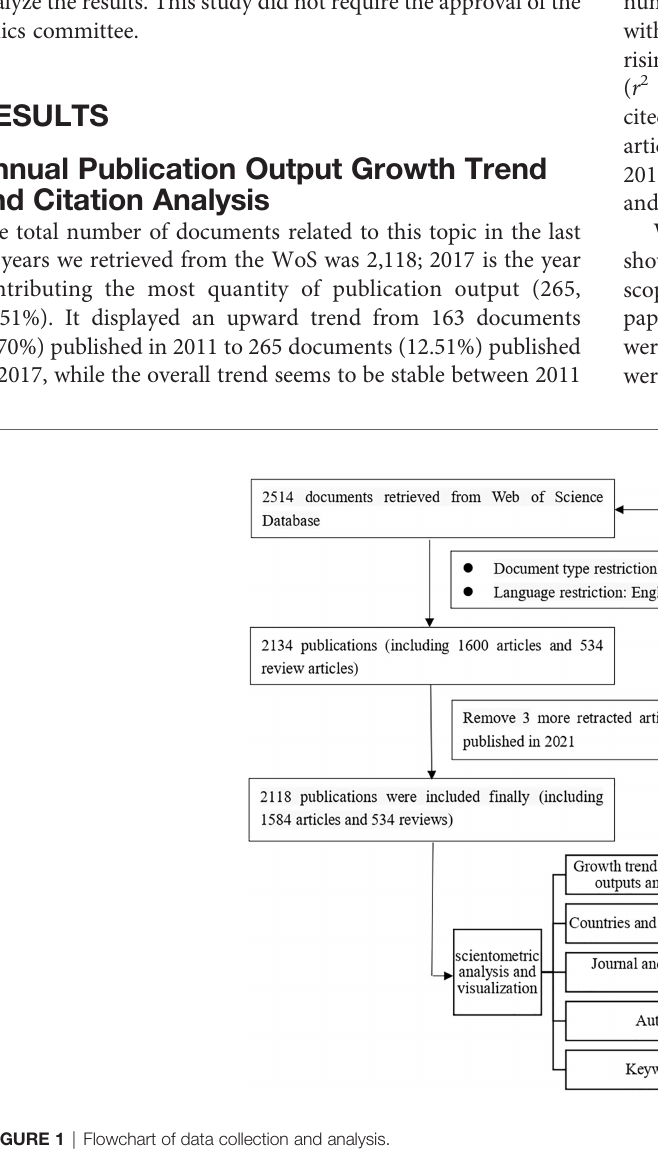
FIGURE 1 | Flowchart of data collection and